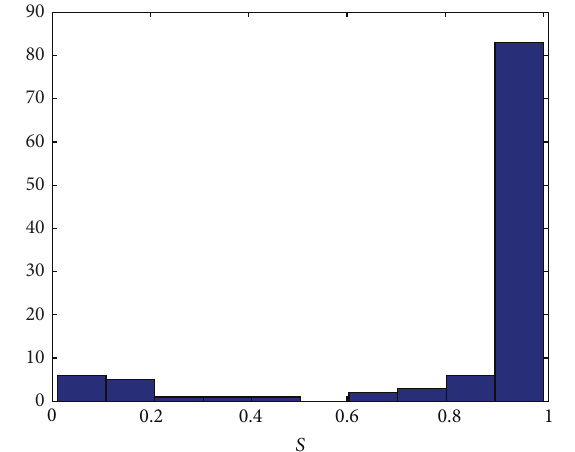
Figure 8: Trajectories of individuals under the external stimuli with algorithm